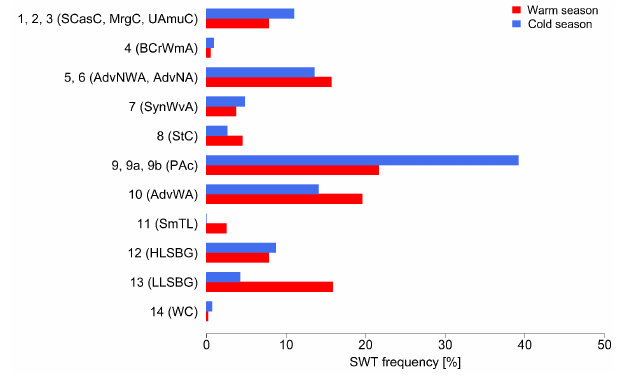
Figure 4. Frequency distributions of daily synoptic weather types by Bugayev’s classification during the cold (September– February) and warm (March–August) seasons in the period of 1935–2014 years. Definitions of SWTs can be seen in Table